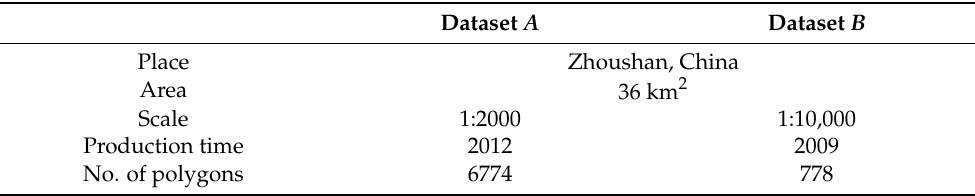
Table 3. Statistical description of experimental data.